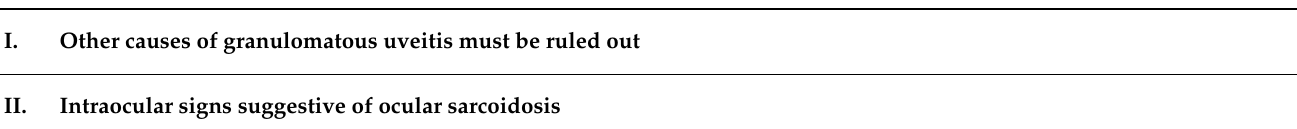
Table 3. Revised criteria of International Workshop on Ocular Sarcoidosis (IWOS) for the diagnosis of ocular sarcoidosis (from [171]).